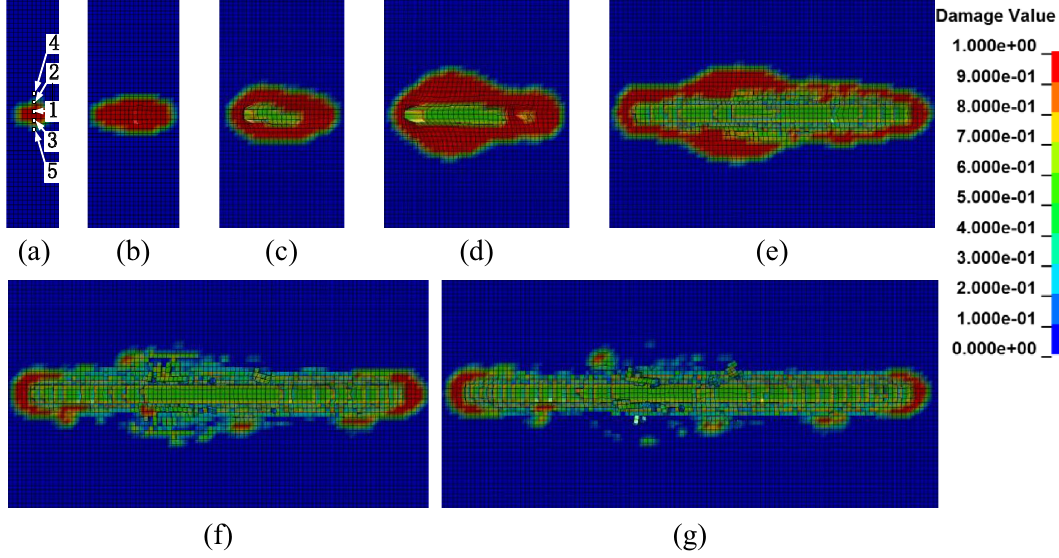
Figure 5. The circular saw blade cutting rock with a cutting depth of 10 mm, feed speed of 0.3 m/min, rotational speed of 3000